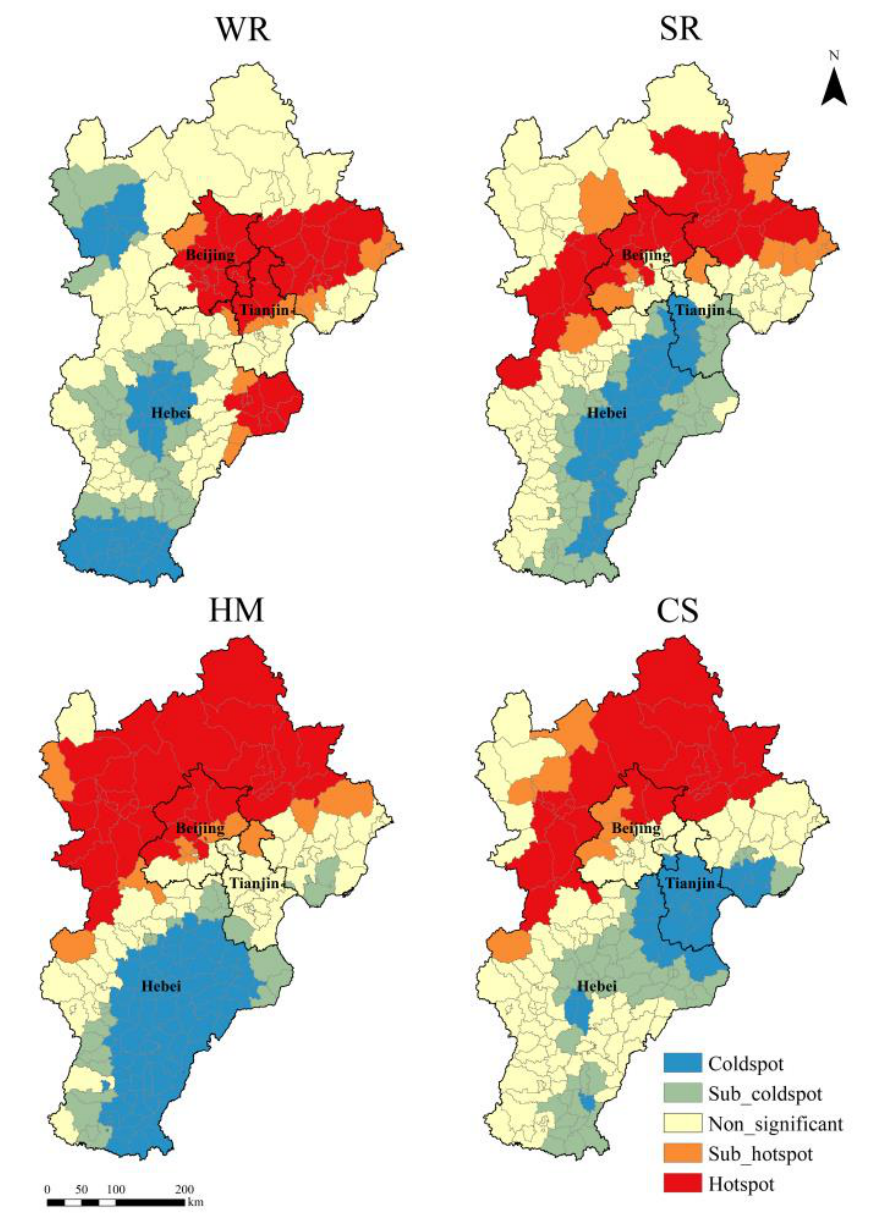
Figure 4. Spatial hot spots and cold spots of ecosystem services in the BTH region, including water retention (WR), soil retention (SR), heat mitigation (HM), and carbon storage (CS). Table 2. Statistics of hot spots and cold spots of ecosystem services.